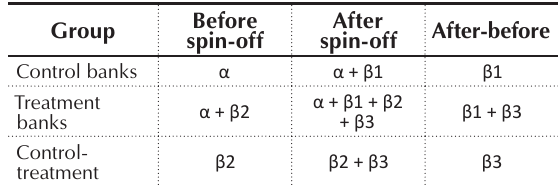
Control- treatment